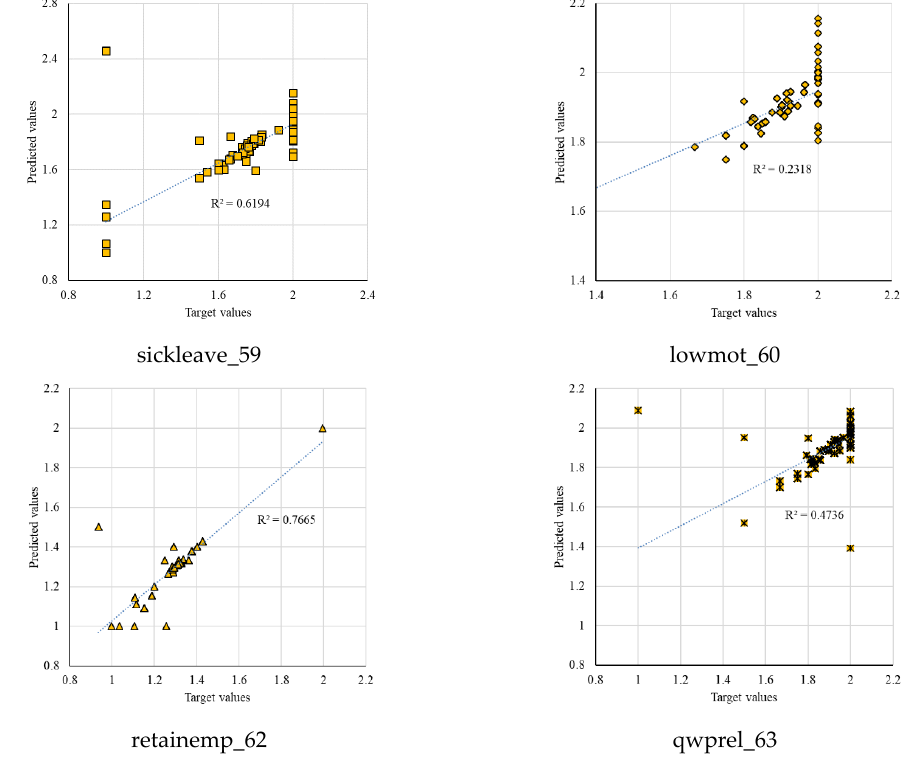
Algorithms 2022 , 15 , x FOR PEER REVIEW Figure 10. Plot diagrams for the effects of the external environment on output values of employee Figure 10. Plotdiagramsfortheeffectsoftheexternalenvironmentonoutputvaluesofemployeewellbeing. wellbeing.